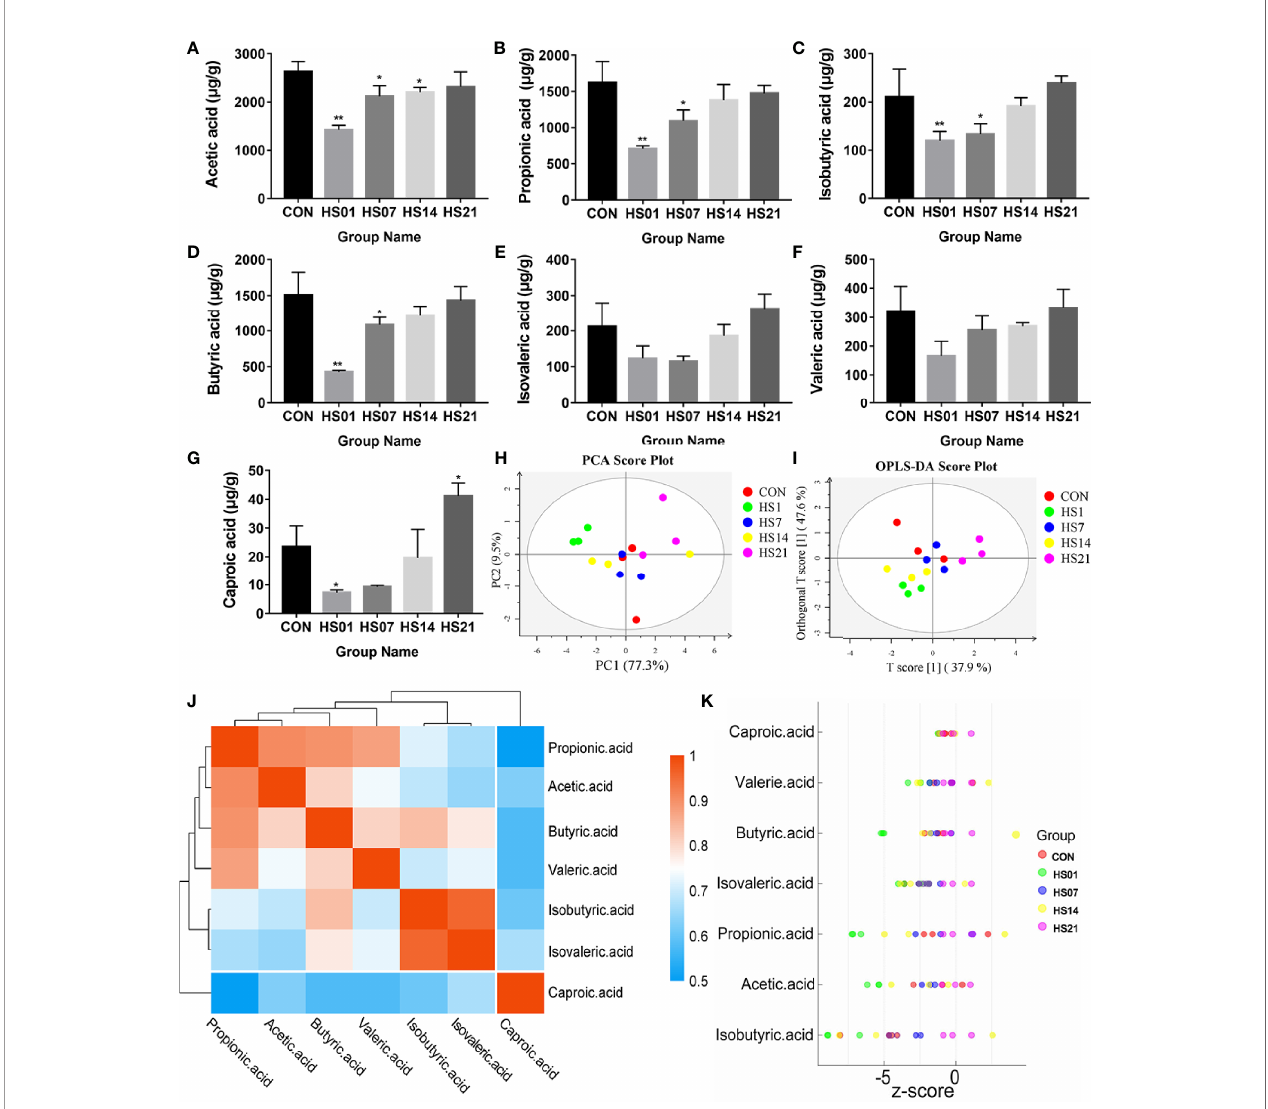
FIGURE 5 | Effect of HS on the metabolism of SCFAs in pig colon. CON indicates no heat stress group of day 1, HS1, 7, 14, 21 indicate heat stress day 1, 7, 14, and 21 groups respectively, n = 4; “ * ” indicates p < 0.05, and “ ** ” indicates p < 0.01. (A) acetic acid; (B) propionic acid; (C) isobutyric acid; (D) butyric acid; (E) isovaleric acid; (F) valeric acid; (G) caproic acid; (H) PCA analysis between short-chain fatty acid samples; (I) short-chain OPLS-DA analysis between fatty acid samples; (J) metabolite correlation analysis; (K) Z-score